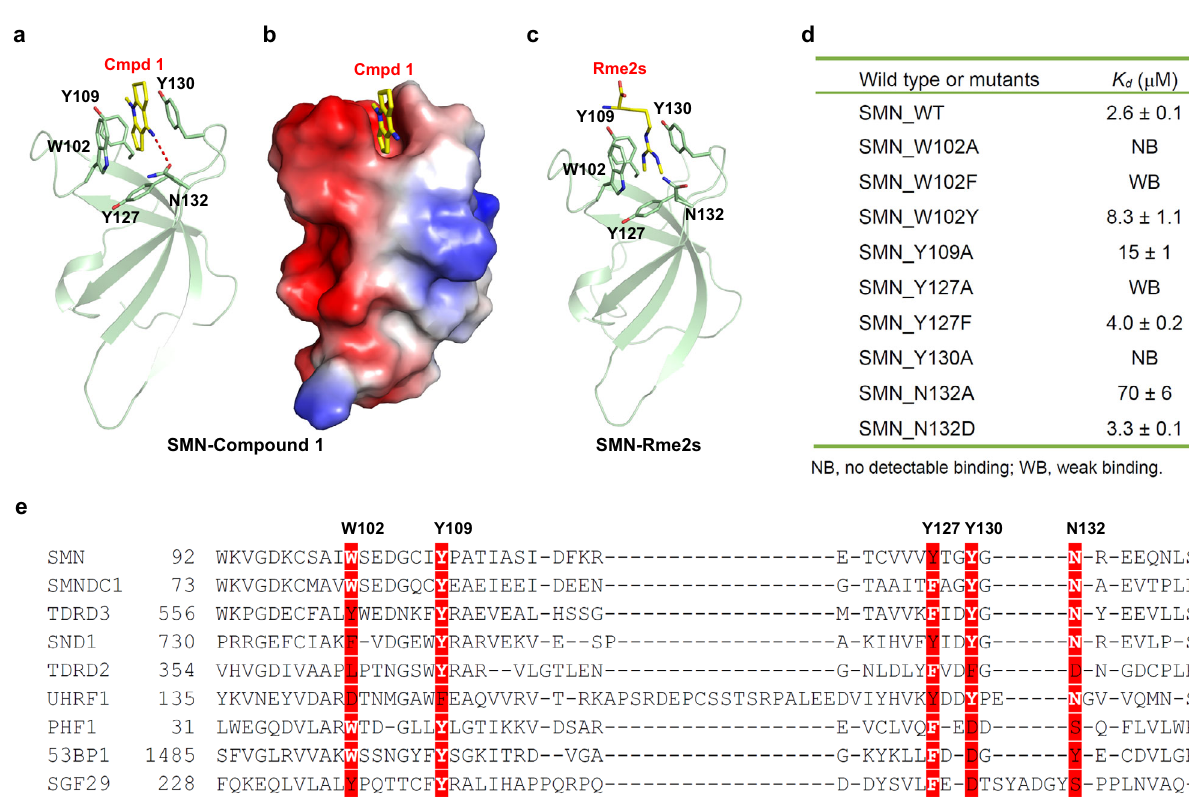
Fig.3|Structuralbasisofpreferentialbindingofcompound 1 toSMN.a Cartoon mode of the complex structure of Tudor domain of SMN and compound 1 . The TudordomainofSMNwascoloredingreen,withtheinteractingresiduesshownin sticks and the intermolecular hydrogen bonds indicated by red dashes. b ElectrostaticpotentialsurfacerepresentationofthecomplexofTudordomainof SMN and compound 1 . c Cartoon modeof the complexstructureofTudordomain of SMN and Rme2s. d Binding af fi nities of compound 1 to different SMN Tudor